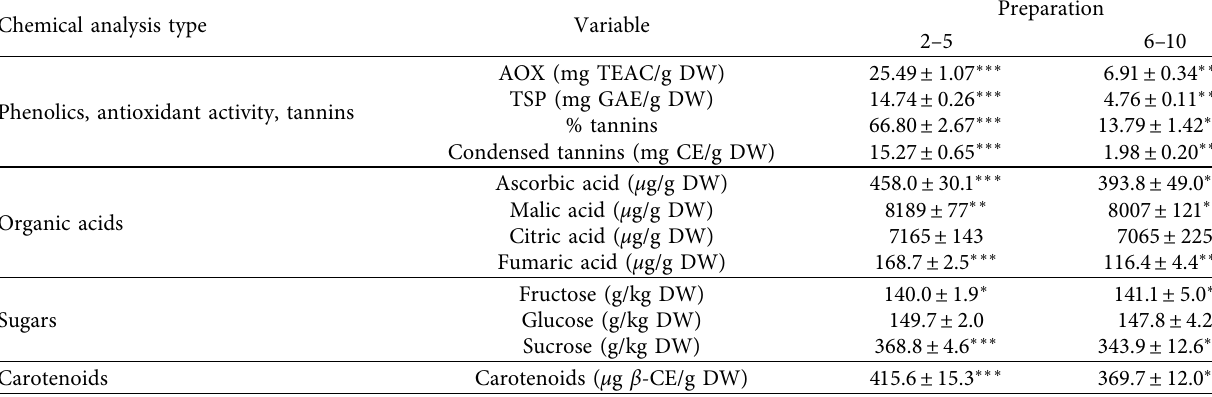
Table 4: Chemical analysis variables.